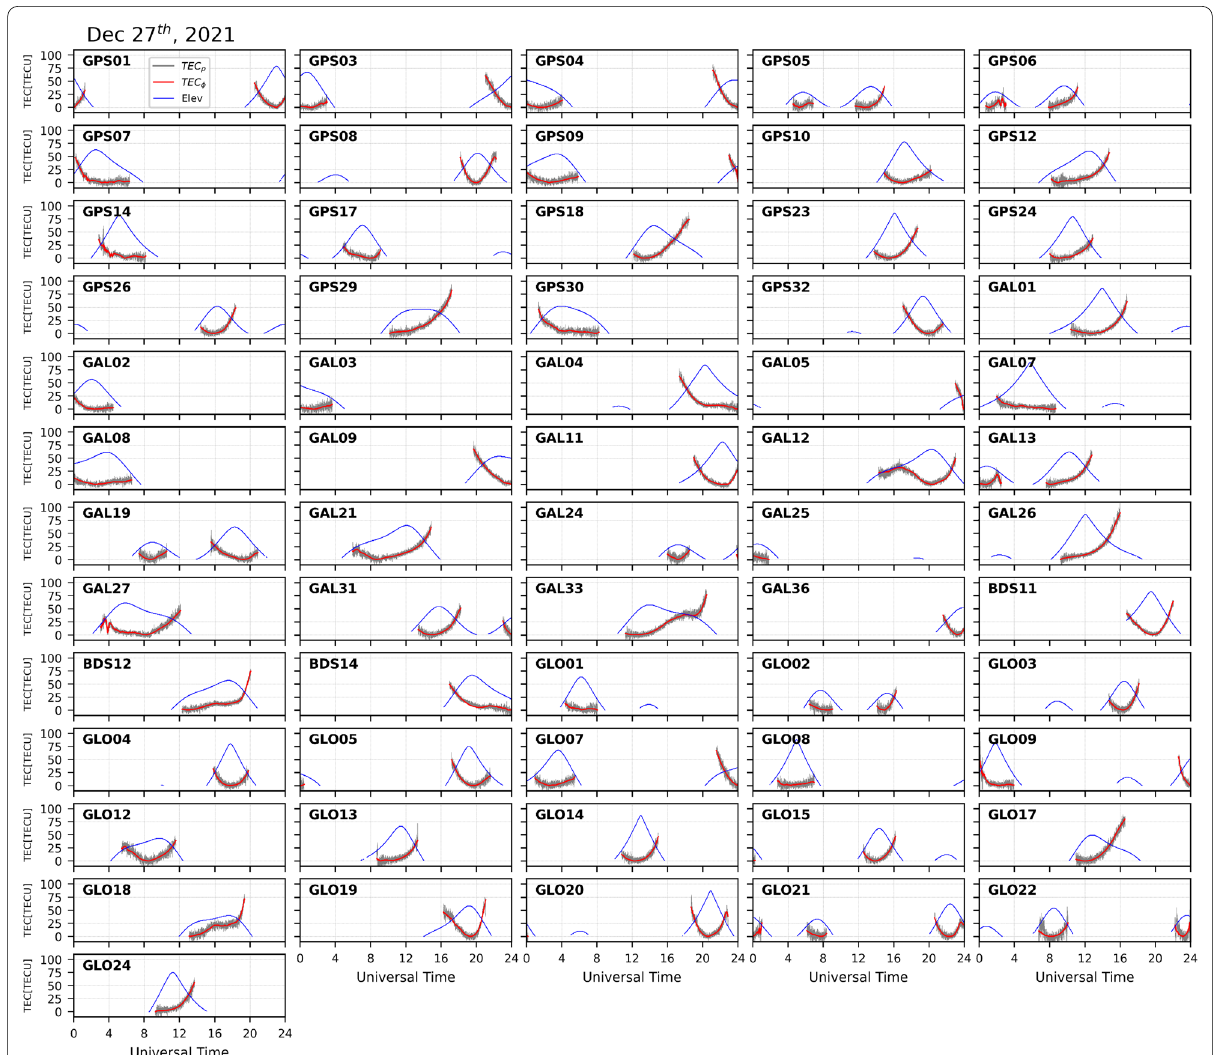
Fig. 7 Example of typical code TEC (gray curves) and phase TEC (red curves) estimates that can be obtained with ScintPi 3.0. Satellite elevation (blue curves) are also shown for